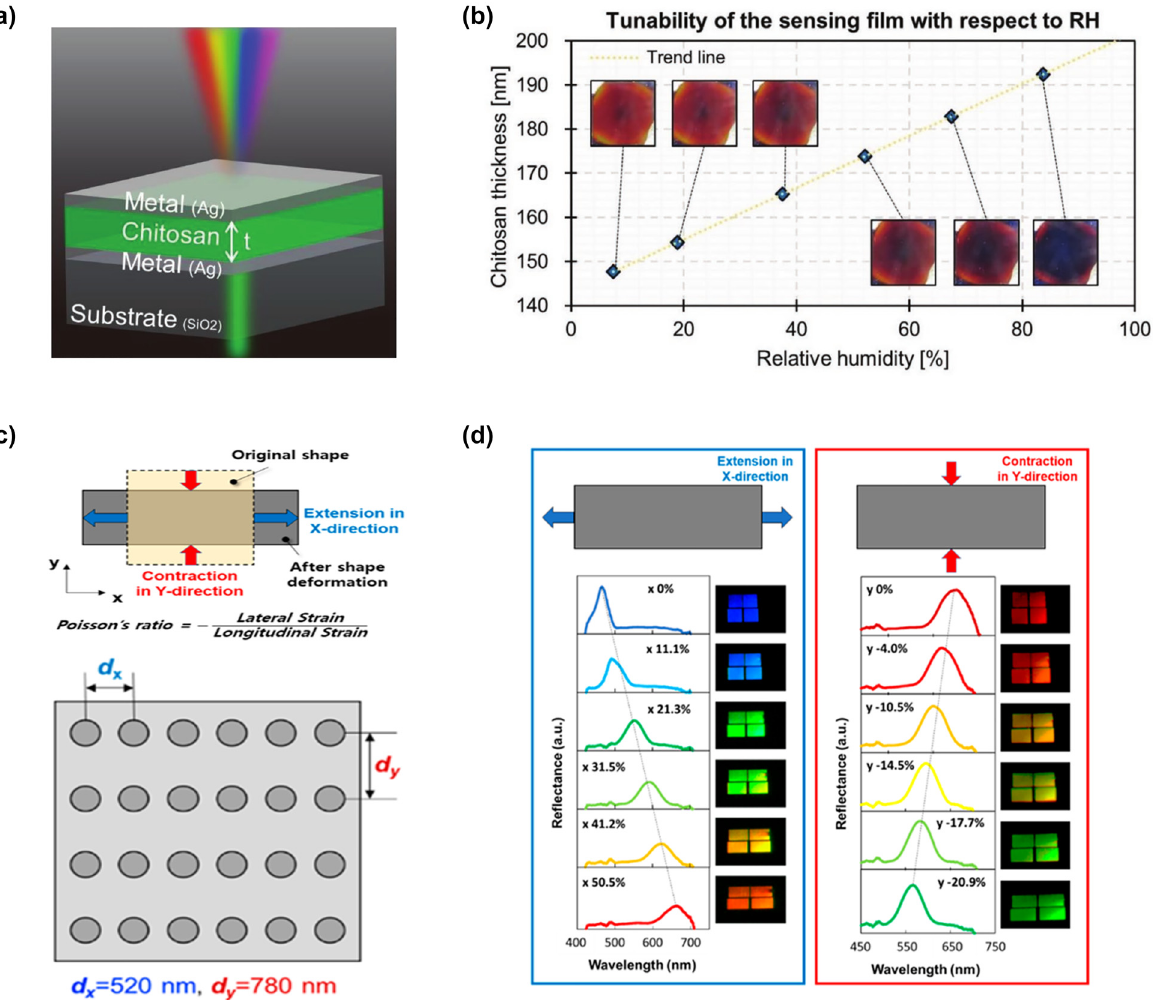
Figure 41: Colorimetric geometric variation sensors. (a) Schematic of the metal–insulator–metal (MIM) structure-based sensor, consisting of two Ag mirrors and a chitosan hydrogel layer in between. (b) Thickness change of the chitosan layer in response to the external relative humidity (RH) variation. Insets: displayed colors of the sensor for different RH values. Reproduced with permission [355]. Copyright 2020, Wiley-VCH. (c) Schematic of the colorimetric strain sensor, whose pitches in the horizontal and vertical directions are asymmetric. (d) Spectrum and color change of the sensor with extension in the horizontal ( X -) direction and contraction in the vertical ( Y -) direction. Modified with permission [356]. Copyright 2020, American Chemical